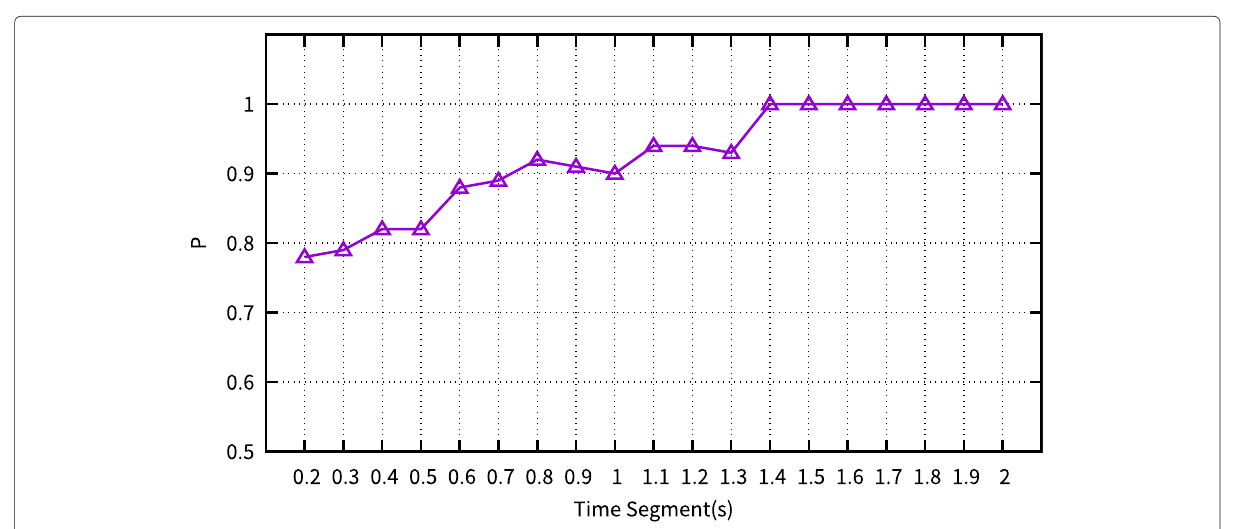
Fig. 4 Correct rate in the case of 3D positioning for V2R